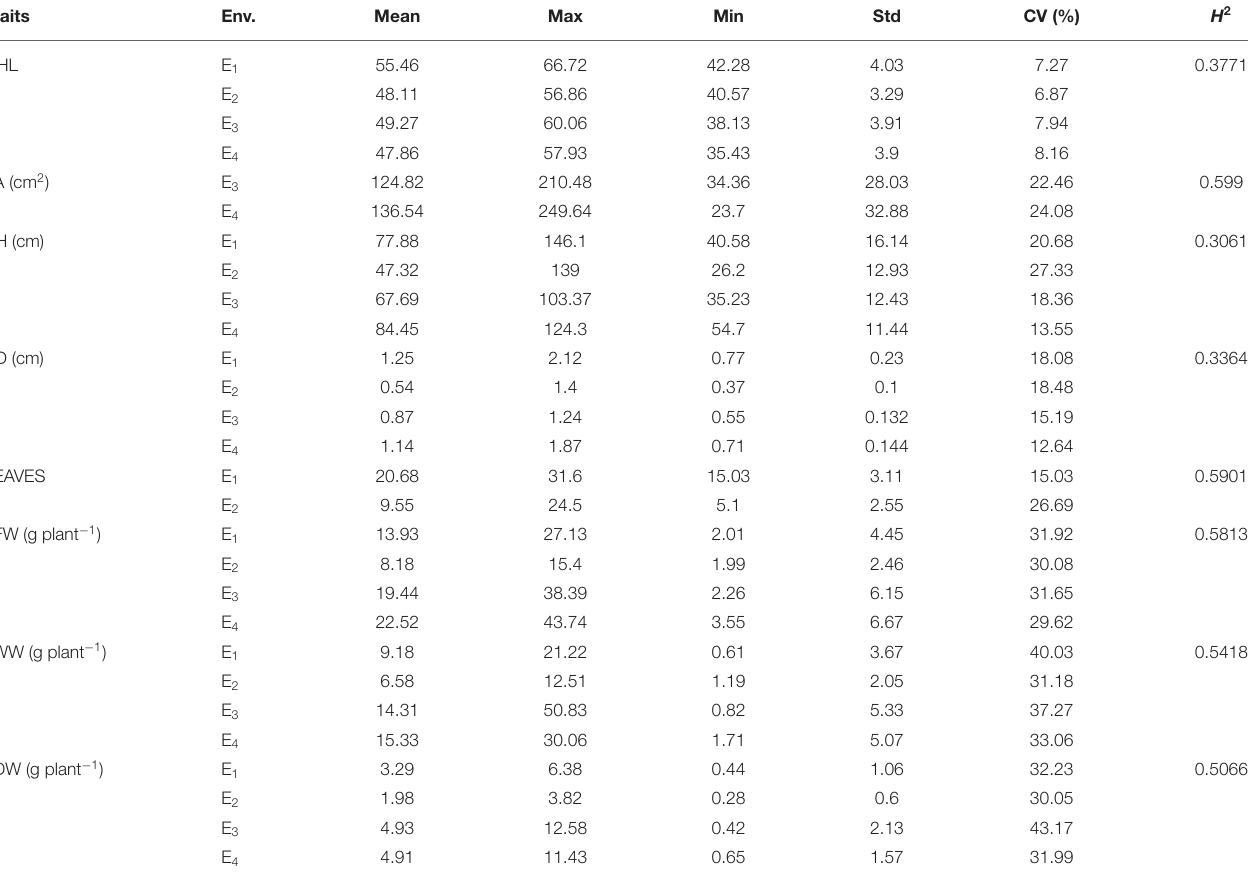
TABLE 1 | Descriptive statistics for the eight drought-tolerance related traits across four environments. Traits Env.